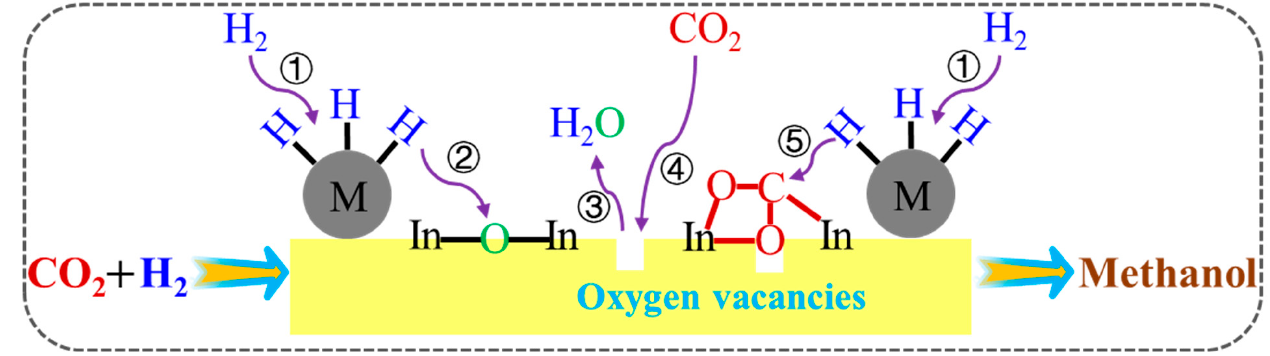
Figure 5. The synergistic catalysis e ff ect of M and In 2 O 3 in CO 2 hydrogenation to methanol.